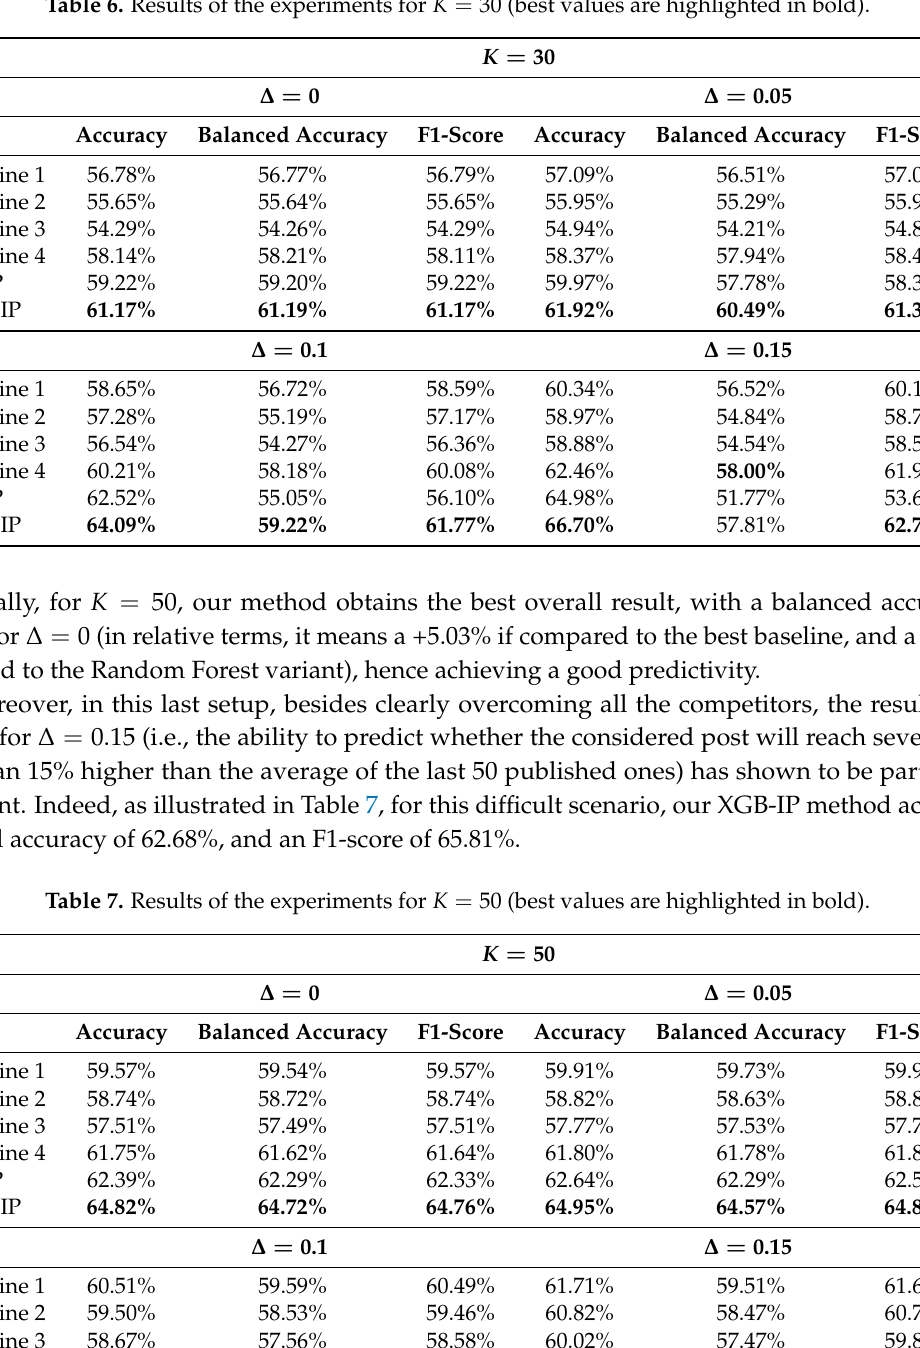
Table 6. Results of the experiments for K = 30 (best values are highlighted in bold).